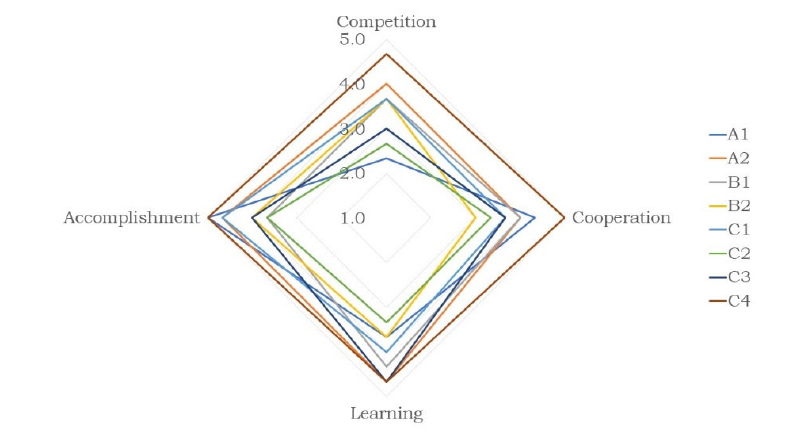
Figure 1. 4-faceted motivation scores of